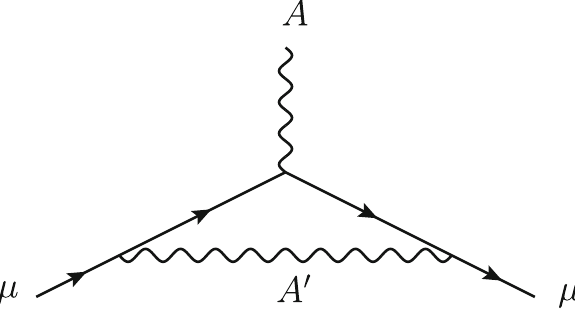
Fig. 2 Contribution of the U ( 1 ) L μ − L τ gauge boson to the anomalous magnetic moment of the muon at energies below the muon mass, q 2 (cid:8) m 2 μ ,